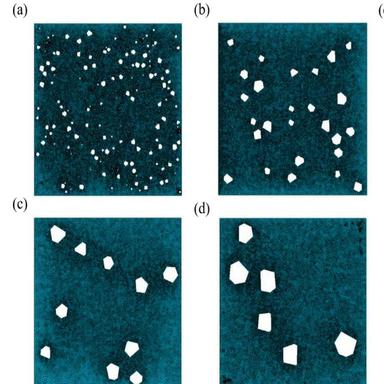
Models for different sizes of micro-voids: (a) size ranges from 1 to 5 μm, (b) size ranges from 5 to 10 μm, (c) size ranges from 10 to 15 μm, (d) size ranges from 15 to 20 μm and (e) refined mesh around the micro-void.